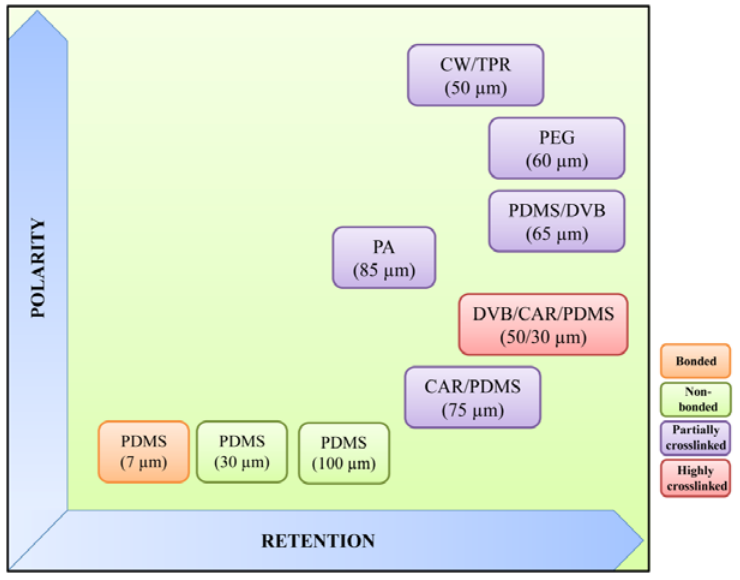
Figure 2. Properties of commercially available SPME fibers (adapted from [31]). CW/TPR, carbowax/templated resin; PEG, polyethylene glycol; PDMS, poly(dimethylsiloxane); DVB, divinylbenzene; PA, polyacrylate; CAR,